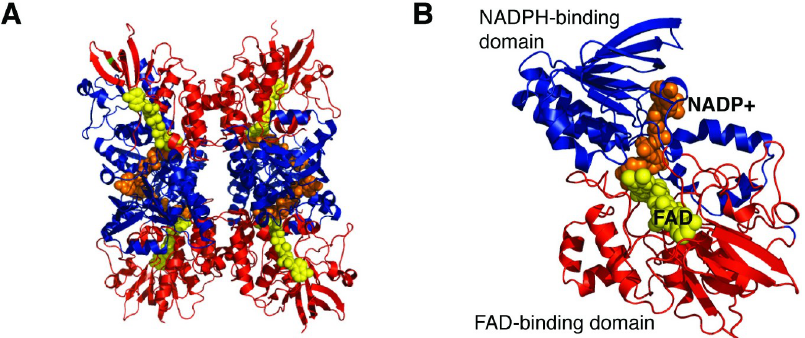
Fig 6. Overall structure of tetrameric Ss DesB in complex with NADP + . NAD + and FAD-bound Ss DesB (PDB code: 6XBB). A) Tetrameric structure of Ss DesB complexed with NADP + illustrating the FAD-binding domain (red- ribbons) and the NADPH-binding domain (blue-ribbons). The bound NADP + molecule is shown in orange spheres and the FAD molecule in yellow spheres. B) A view of the Ss DesB protomer. https://doi.org/10.1371/journal.pone.0248385.g006 8 protomers in the asymmetric unit. The nicotinamide ring is held in position by hydrogen bonding interactions between the nicotinamide N7N atom and main chain carbonyl oxygen atom of H59 and the N5 atom of the FAD isoalloxazine ring. The nicotinamide O7N atom par- ticipates in water-mediated hydrogen bonding interactions via water 679 to the E202 side chain and H50 main chain carbonyl oxygen atom. The side chain of Q61 also contributes to stabilizing interactions via a hydrogen bond between the side chain OE1 oxygen atom and the